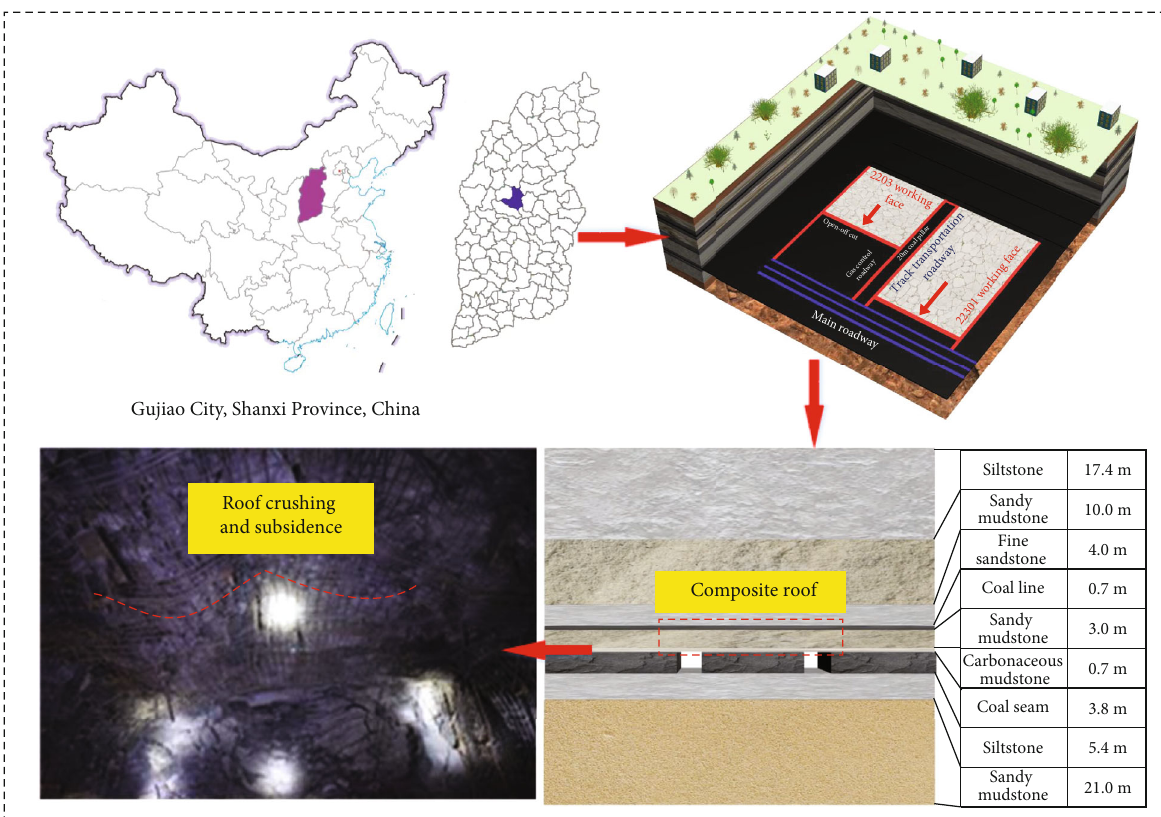
Figure 5: Schematic diagram of geological conditions of gas control roadway in 22301 working